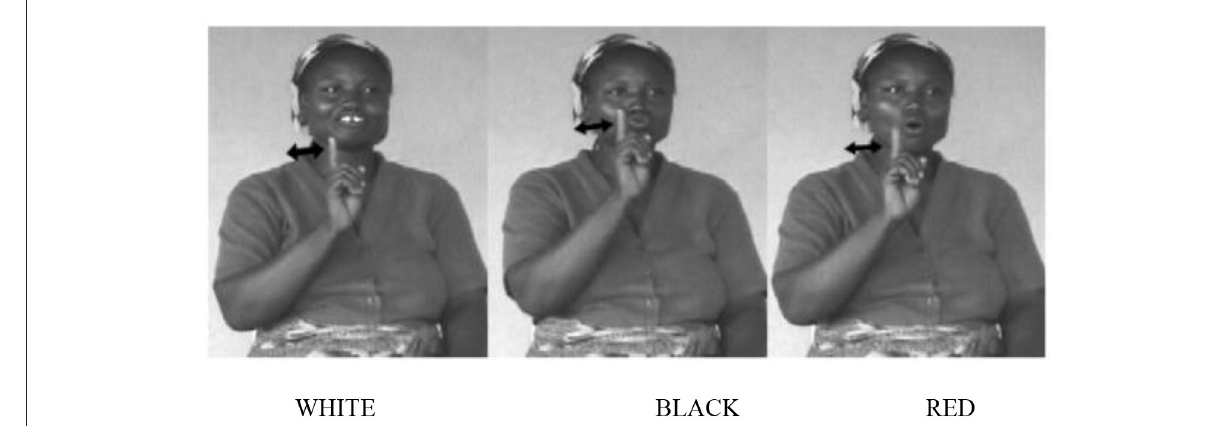
FIGURE1 Signs for “white,” “black,” and “red” in Adamorobe Sign Language (reprinted with permission from Nyst, 2007, p. 93).